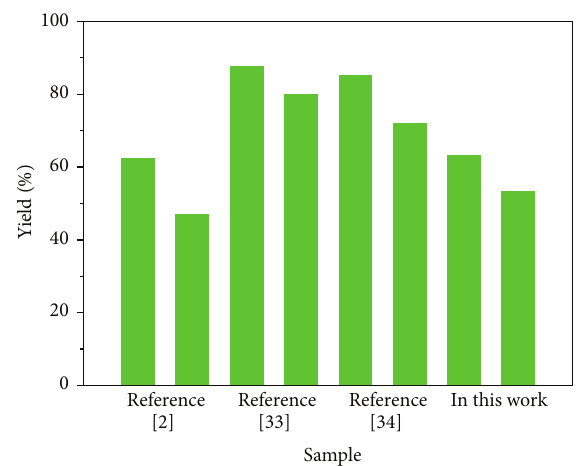
Figure 8: Comparison of the results in this work with the previous literature.